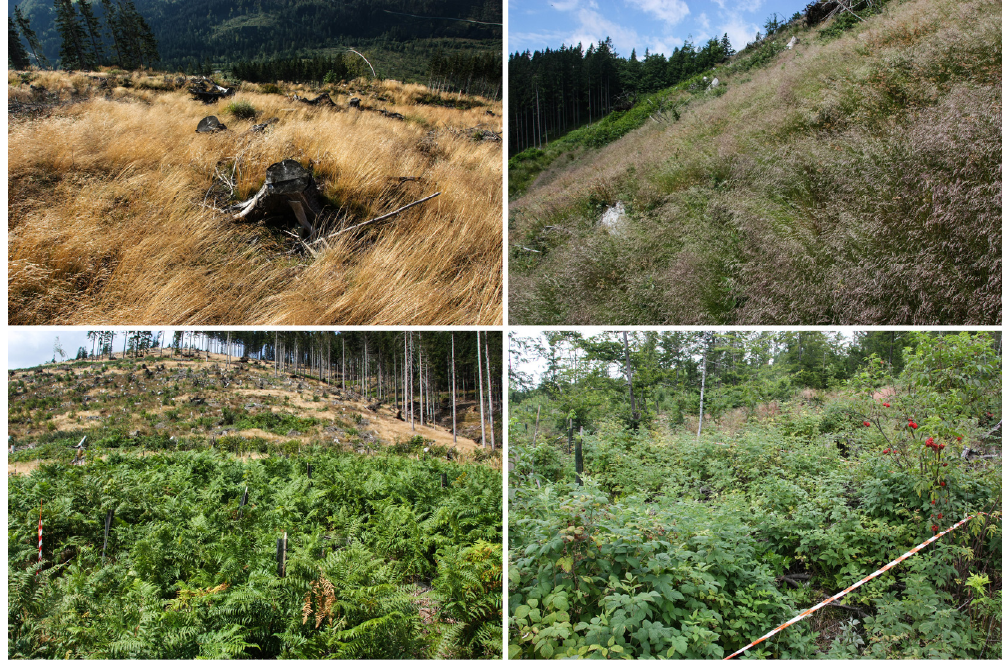
Figure 4. Competing grass ( Avenella flexuosa (L.) Drejer) inhibits the natural regeneration on a steep, southern slope of Č rnivec nine years after windthrow (upper images). Thick ground vegetation at mid (lower left) and lower slope (lower right) positions with deep and moist soils also hinder natural regeneration.